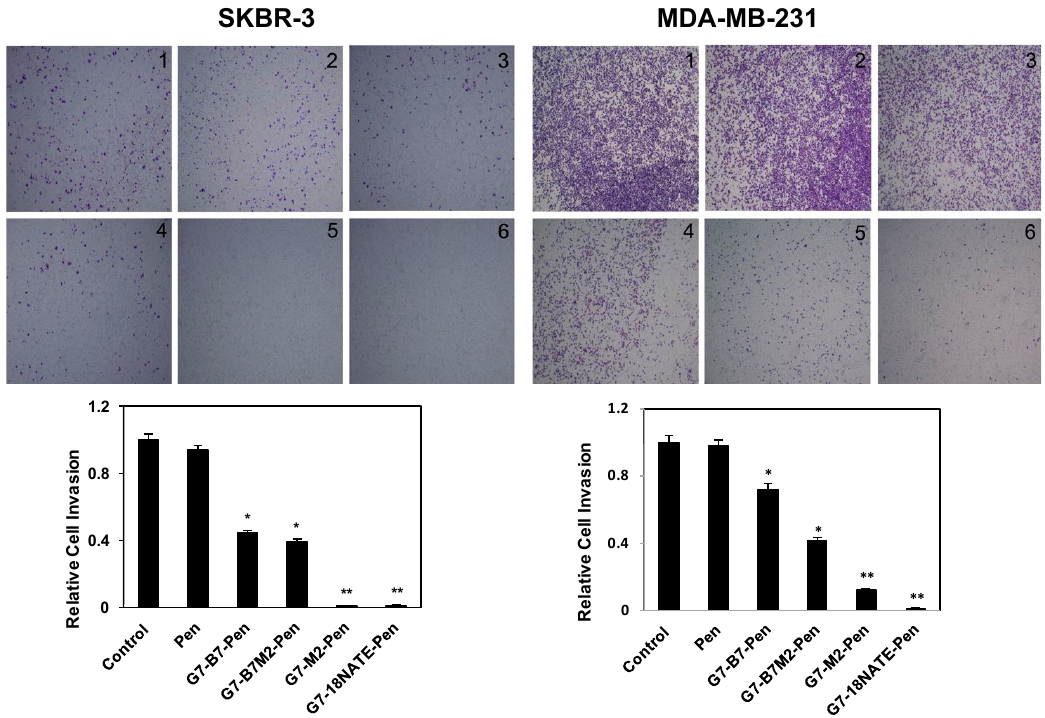
Figure 6. E ff ect of the Grb7 peptide inhibitors on ( left ) SKBR-3 and ( right ) MDA-MB-231 cell invasion. Top: Representative images of the Transwell invasion assay demonstrating that 20 µ M G7-peptide inhibitors for 48 h (SKBR-3) or 24 h (MDA-MB-231) inhibit invasion through the Matrigel-coated filters (image 1, Control; 2, Pen; 3, G7-B7-Pen; 4, G7-B7M2-Pen; 5, G7-M2-Pen; 6, G7-18NATE-Pen). Bottom: Relative cell invasion is expressed relative to the untreated control cells, which is normalized to 1.0. Bars represent mean ± SEM for at least three independent experiments with duplicate samples. A student ′ s t test was performed between control and G7-peptide treated samples with * p < 0.05, ** p < 0.01.